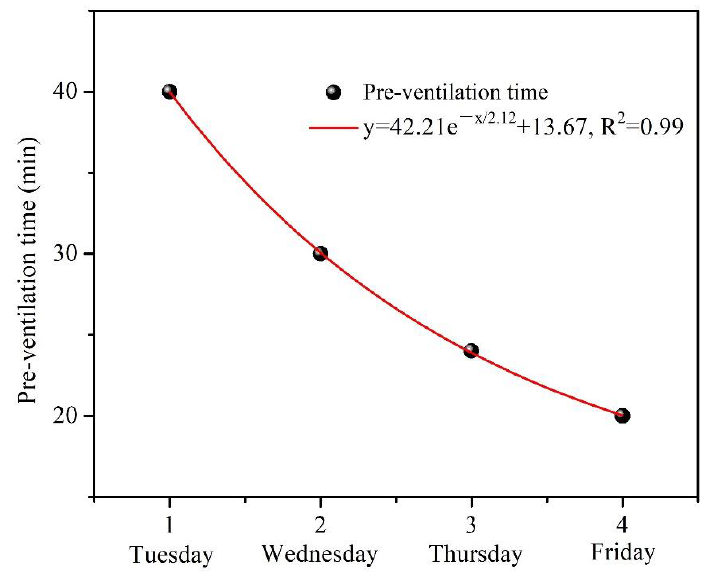
Figure 10. Pre-ventilation time from Tuesday to Friday in Week III.